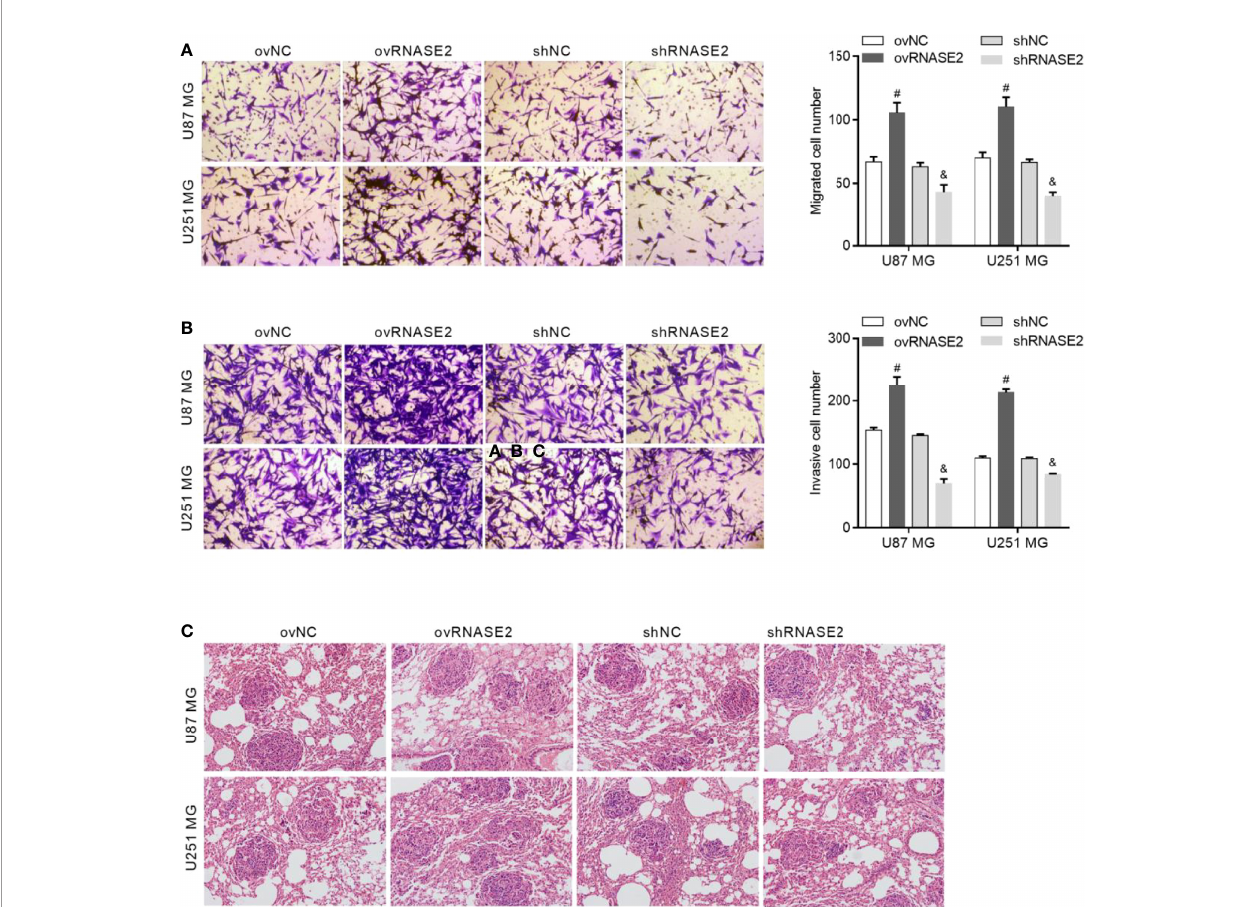
FIGURE 4 | RNASE2 overexpression promotes the migration and invasion of U87 MG and U251 MG cells, while RNASE2 knockdown suppresses it. RNASE2- overexpressing (ovRNASE2) and RNASE2-silenced (shRNASE2) cells were constructed. The ovNC and shNC groups were used as control cells. (A) Transwell assay showing that RNASE2 overexpression increased the number of migrating cells, while RNASE2 knockdown reduced it. (B) Transwell-Matrigel assay showing that RNASE2 overexpression increased the number of invasive cells, while RNASE2 knockdown reduced it. (C) Lung metastasis model in nude mice showing that RNASE2 overexpression increased the number of tumor loci in lung tissue, and that RNASE2 knockdown reduced it. # indicates p < 0.05; ovRNASE2 versus ovNC. & indicates p < 0.05; shRNASE2 versus shNC.